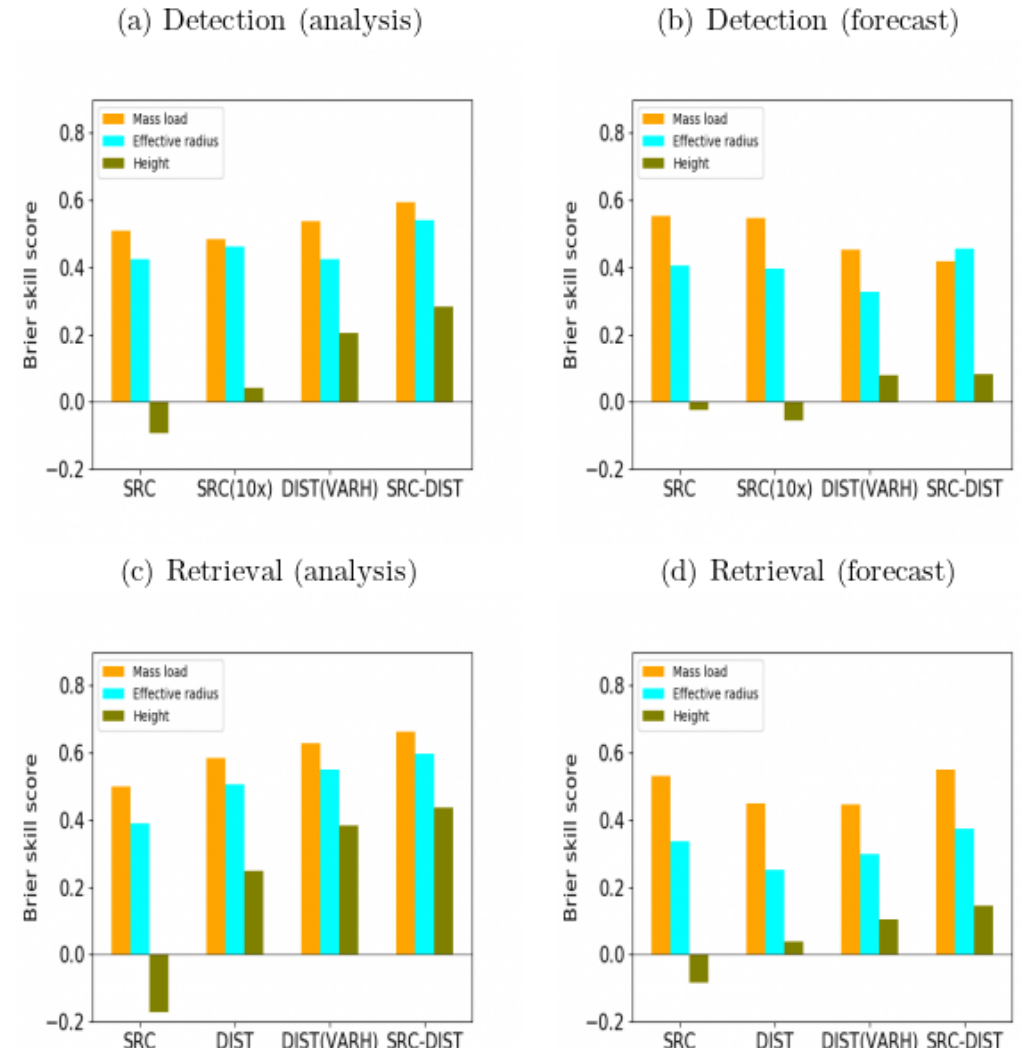
Figure 2. Brier skill scores of ash mass load, effective radius, and cloud top height averaged over 14 eruption case studies for ( a ) detection-based analyses, ( b ) detection-based forecasts, ( c ) retrieval-based analyses, and ( d ) retrieval-based forecasts. Different initialization methods (SRC, SRC(10×), DIST, DIST(VARH), and SRC-DIST) are considered for each of these runs, as further described in Table 1.